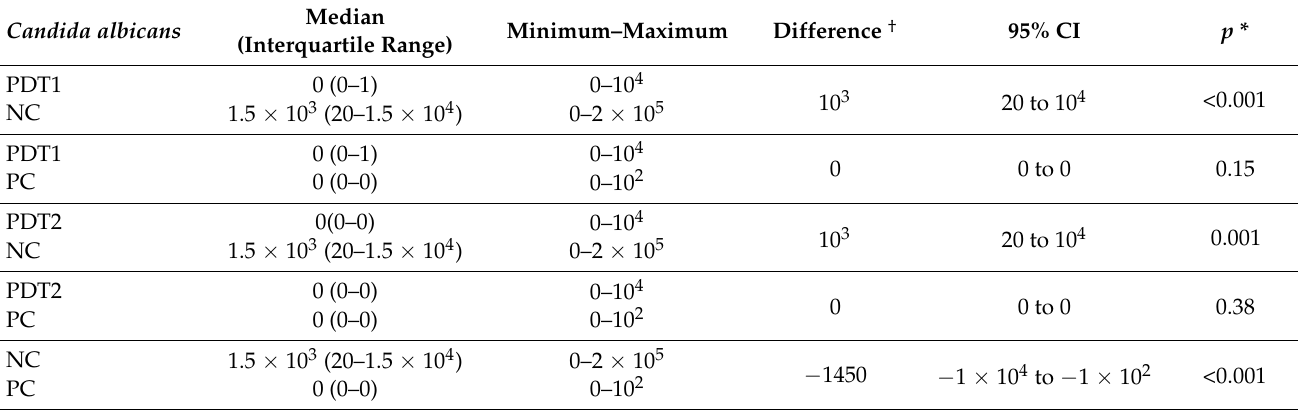
Figure 12. Difference in the number of Staphylococcus aureus CFUs between groups (NC, PC, PDT1, PDT2). (cid:78) Outliers; * Statistically significant difference. Table 2. Differences in Candida albicans CFUs between groups (NC, PC, PDT1, PDT2).